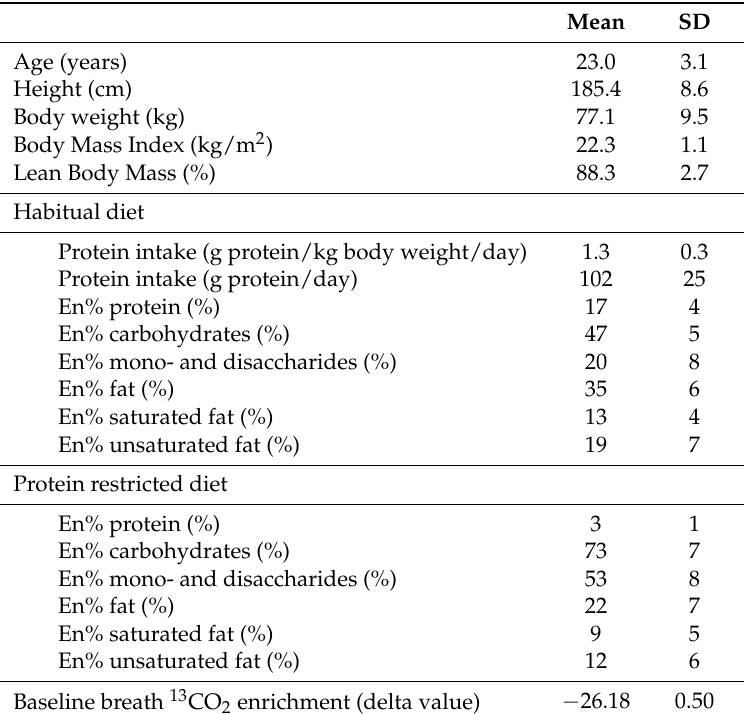
Table 1. Baseline characteristics of the subjects ( n =